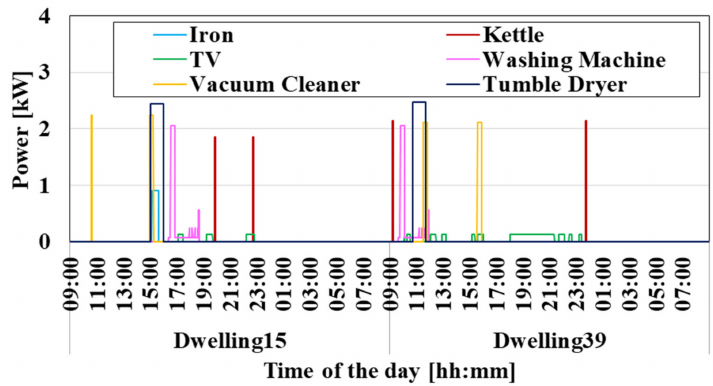
Figure 2. Resiliency-sensitive load–demand of dwelling15 and dwelling39.